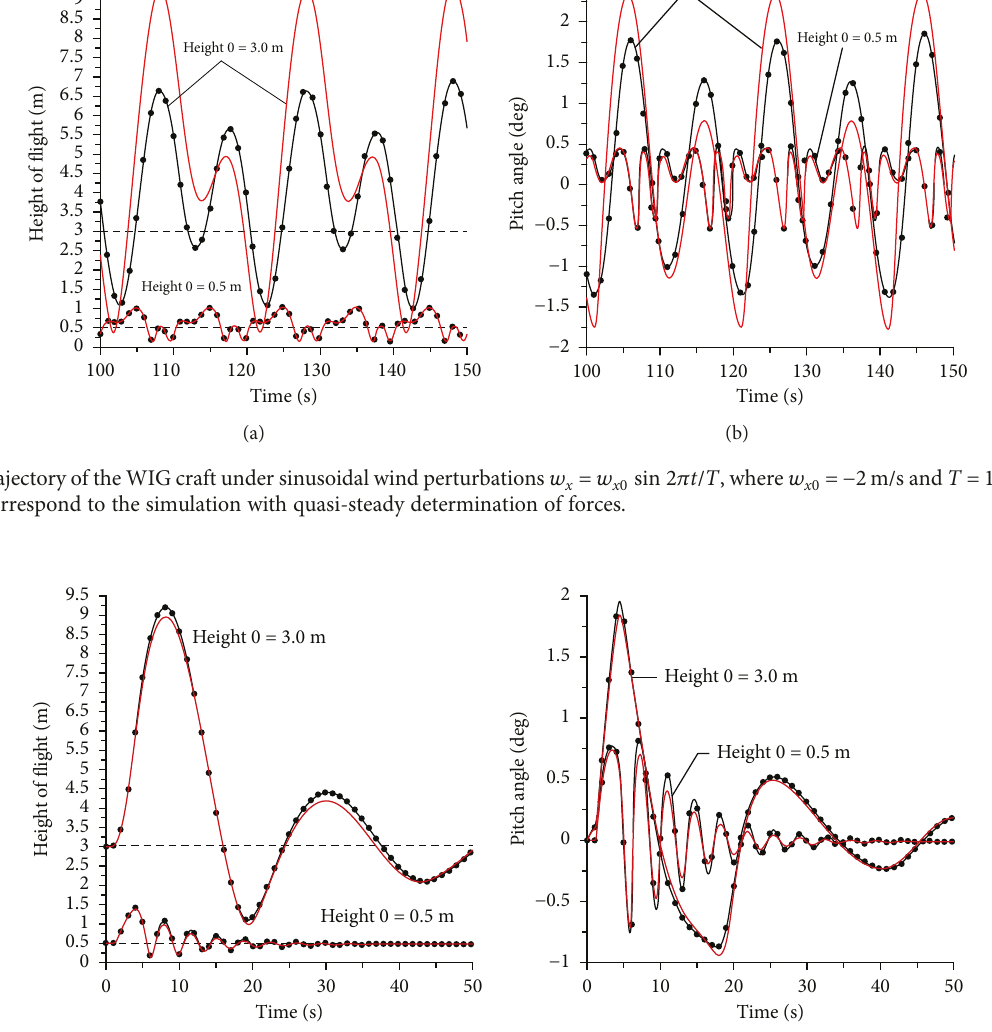
Figure 12: Trajectory of the WIG craft under step-like wind perturbations. Black lines with circles correspond to the simulation with quasi- steady determination of